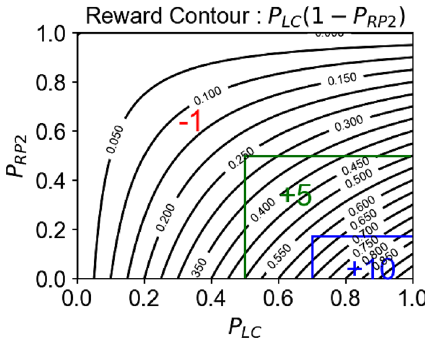
Figure 6. Reward function for reinforcement learning. Contour plot of reward function as a function of the probability of local control (PLC) and radiation induced pneumonitis of grade 2 or higher (PRP2). Area enclosed by the blue line corresponds to the clinically desirable outcome, i.e., P LC > 70% and P RP 2 < 17.2% . Similarly, the area enclosed by the green lines corresponds to the computationally desirable outcome, i.e., P LC > 50% and P RP 2 < 50% . Along with P LC × ( 1 − P RP 2 ) the AI agent receives + 10 reward for